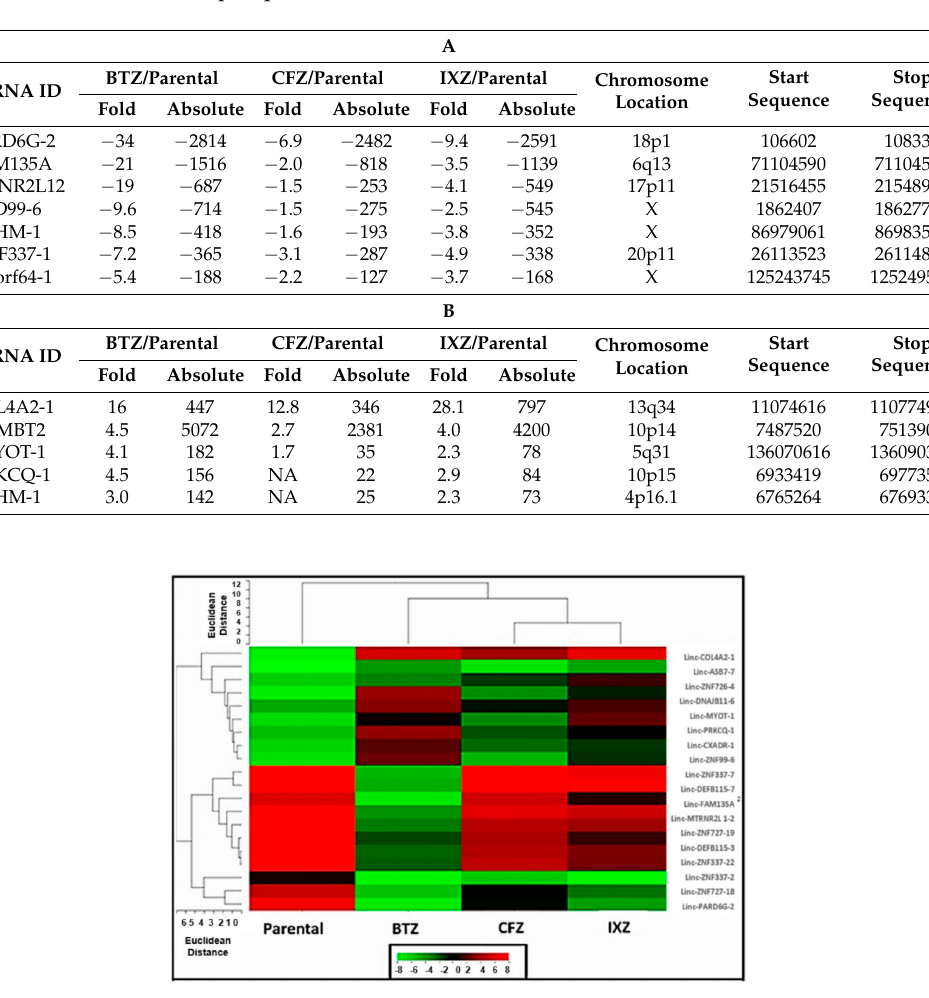
Figure 4. Heat map of long non ‐ coding RNAs (lncRNAs) deregulated in bortezomib (BTZ) ‐ , carfilzomib (CFZ) ‐ , and ixazomib (IXZ) ‐ resistant cells relative to parental cells. Shown are the lncRNAs significantly up ‐ or downregulated in each PI ‐ resistant cell line relative to drug ‐ naïve parental cells. Genome ‐ wide non ‐ coding RNA (ncRNA) expression profiles from drug ‐ resistant cells were compared to those of drug ‐ naïve parental cells treated with vehicle alone (0.05% DMSO).